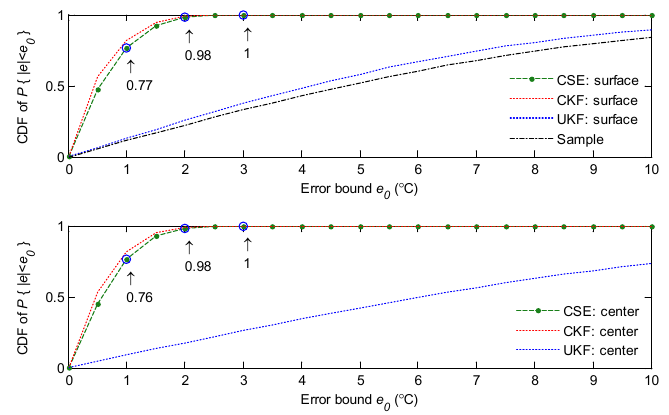
Figure 8. The CDF of the absolute estimation